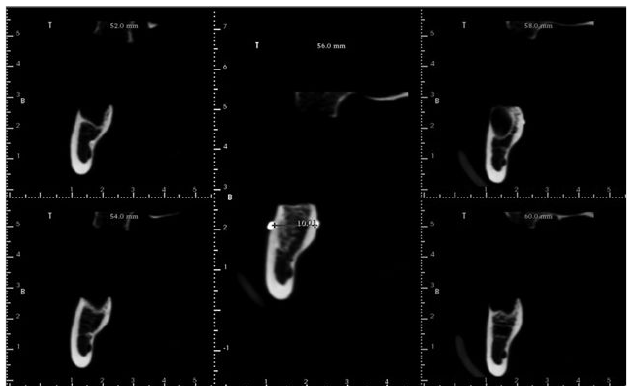
Fig. 2. CBCT cross-sectional image of a marked mandibular edentulous site, which was digitally measured by using the imaging software.